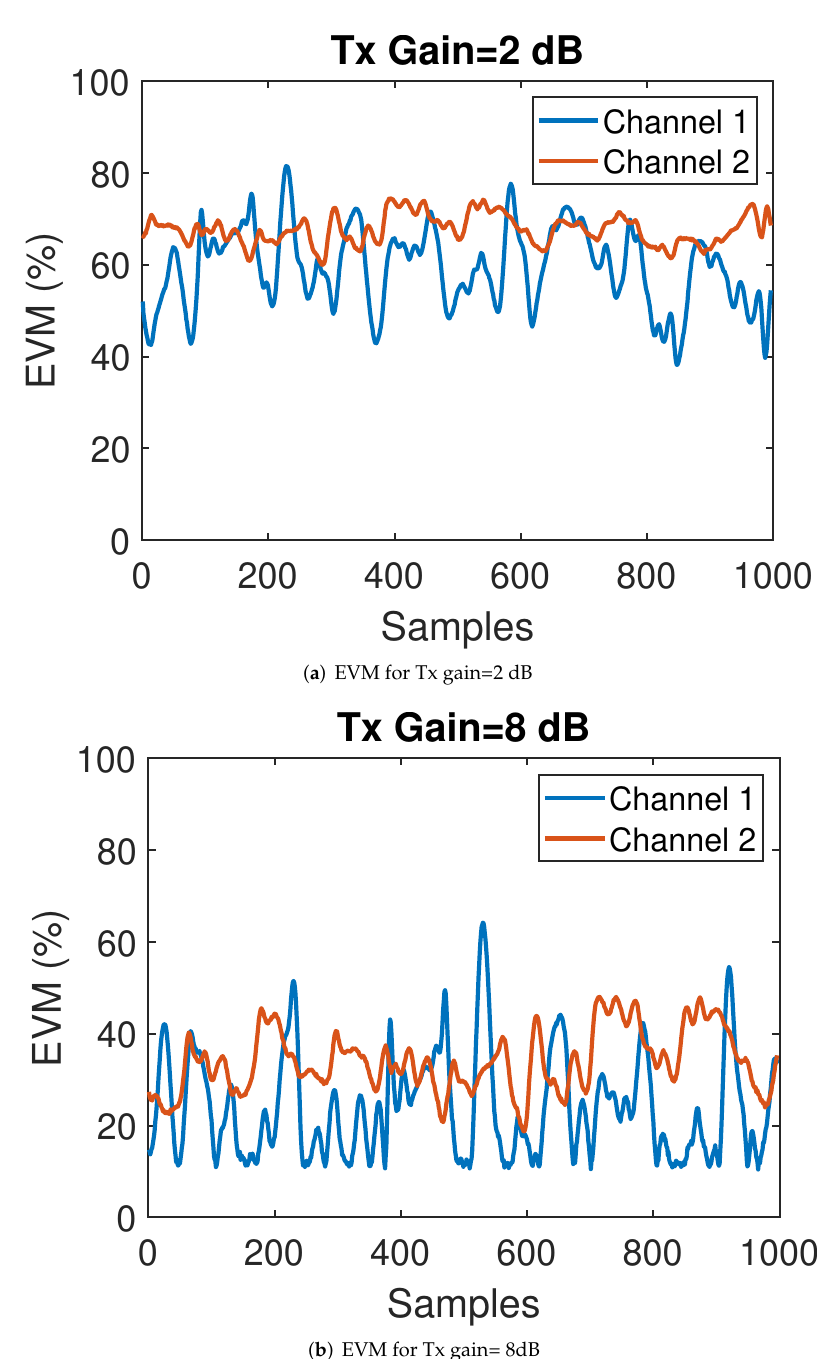
Figure 5. Channel 1 and channel 2 instantaneous EVM measurements at 5.6 GHz in a mode-stirred metal enclosure. AGC gain = 60 dB, Rx gain = 0 dB, and Tx gain varied from 2 dB to 8 dB with the step of 2